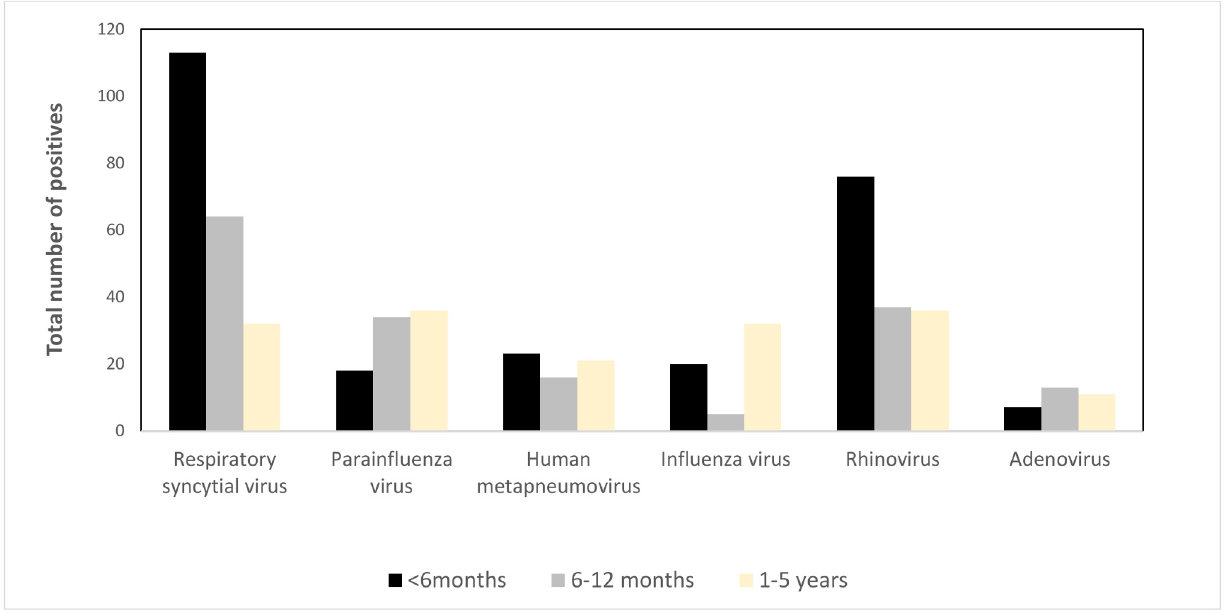
Fig 1. Cumulative age-specific viral etiology of hospitalized children with respiratory illness aged < 5 years enrolled in the four surveillance hospitals, Bangladesh, 2010 –